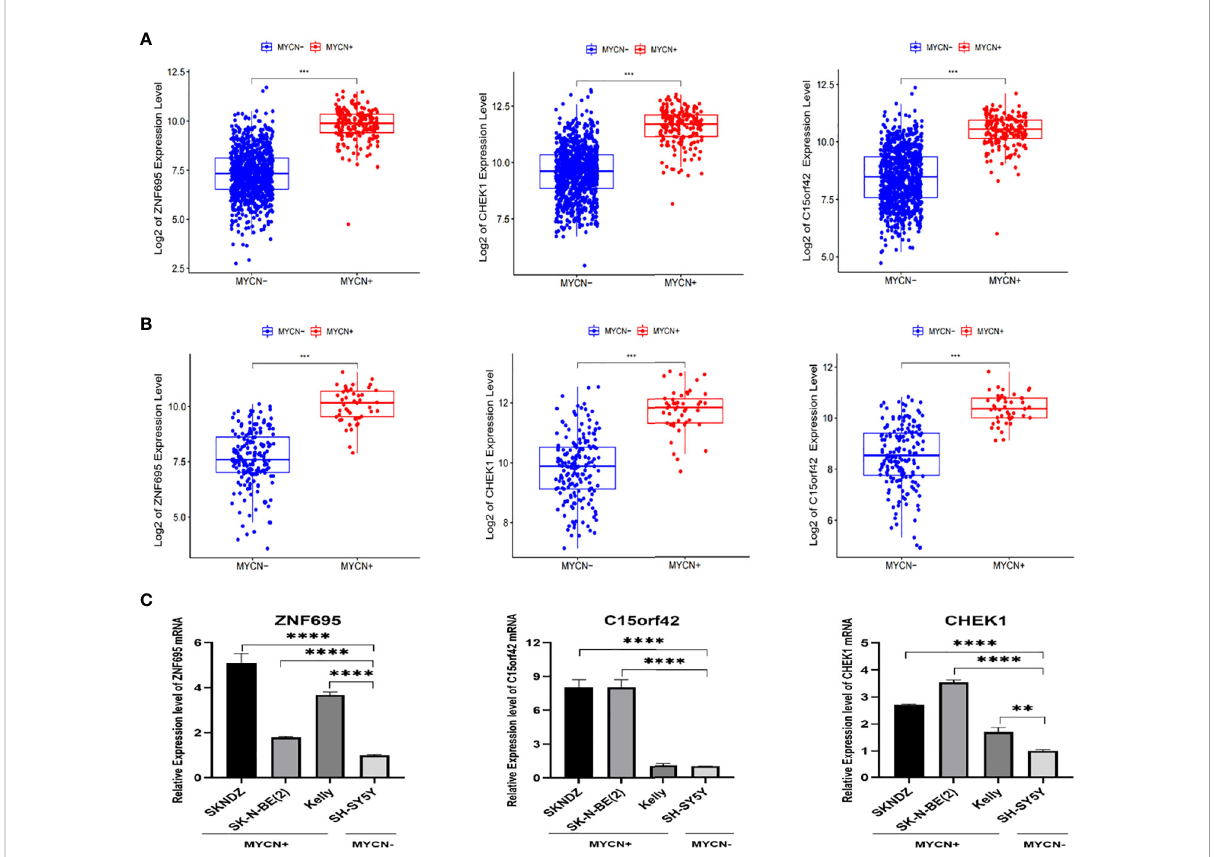
FIGURE 7 Validation of correlation between ZNF695 , CHEK1 , C15ORF42 and MYCN positive NB (A) The comparison of the expression levels of the hub genes between the MYCN positive and negative group with a total of 1136 NB cases. (B) The comparison of the expression levels of the hub genes between the MYCN positive and negative group in validation set. (C) The comparison of the expression levels of the hub genes between the MYCN positive (SKNDZ, Kelly, SK-N-BE(2)) and negative (SH-SY5Y) cell lines. (**p<0.01, ***p<0.001,